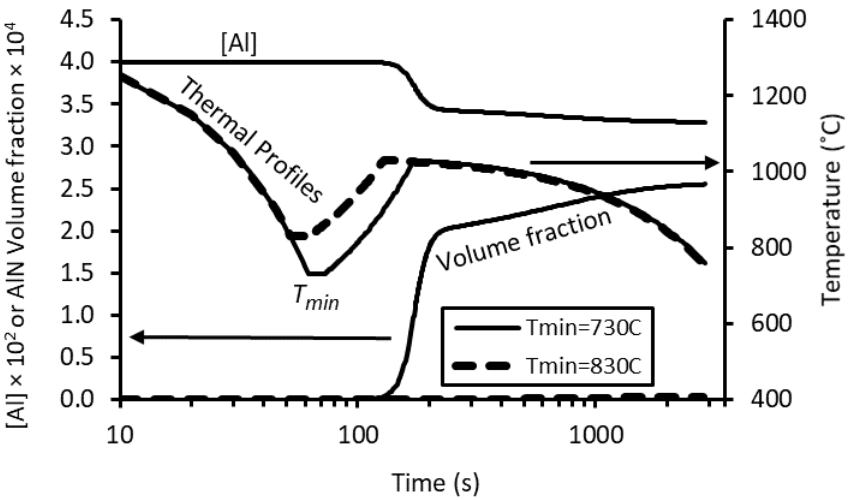
Figure 9. AlN volume fraction in ferrite (bcc) and total solute Al predicted by TC-PRISMA [9] as a function of T min thermal profile (temperature-time) to a rebound temperature of 1030 °C and during subsequent secondary cooling.